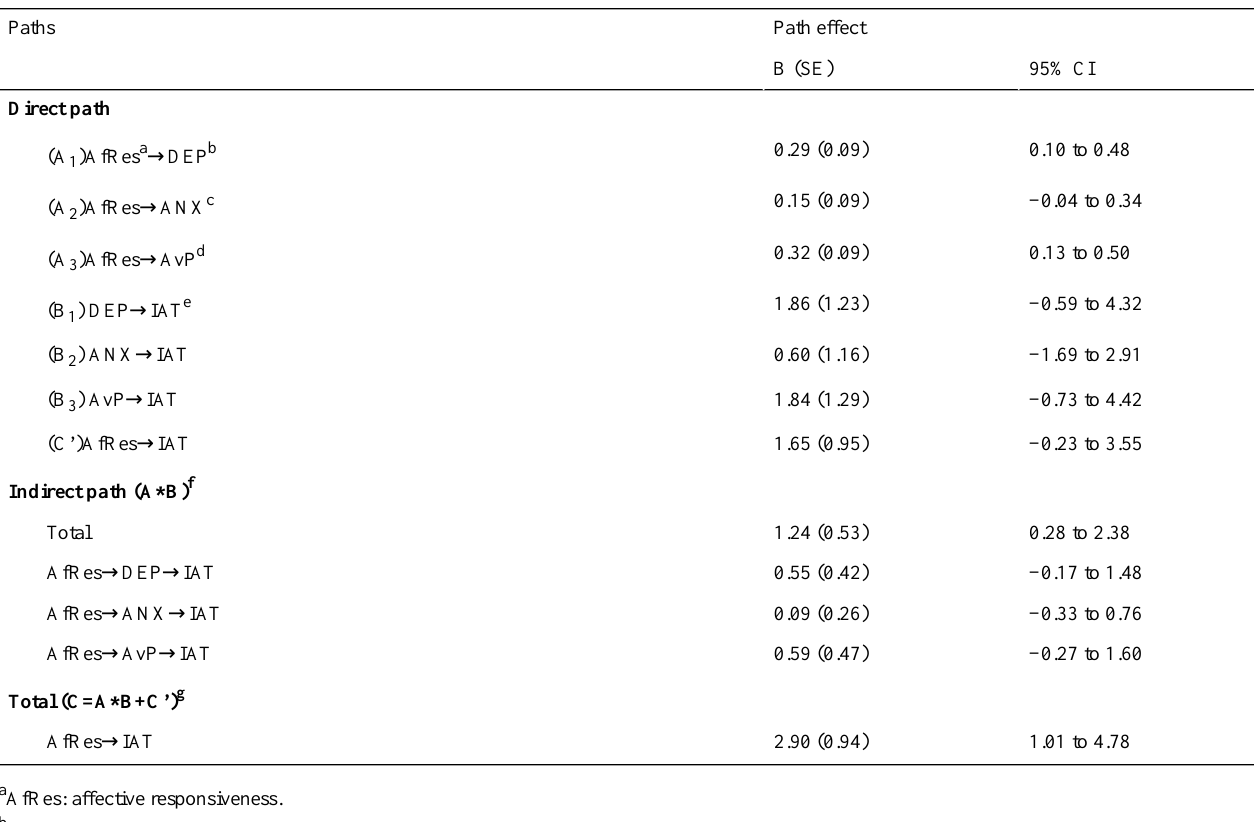
Table 7. Multiple mediator model showing total, direct, and indirect effects of affective responsiveness on internet